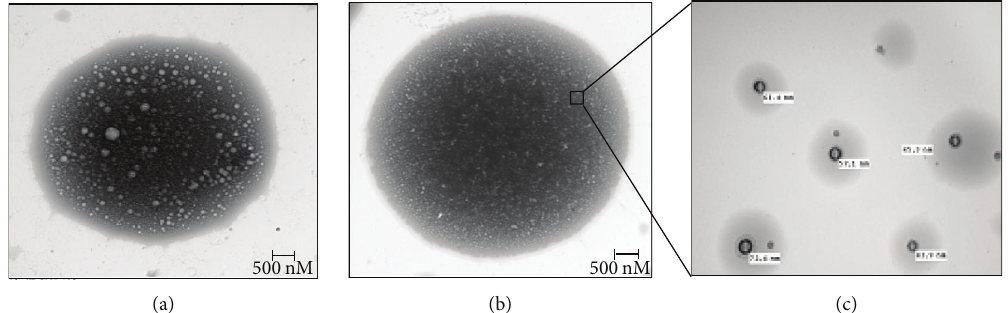
.163.325.488.650